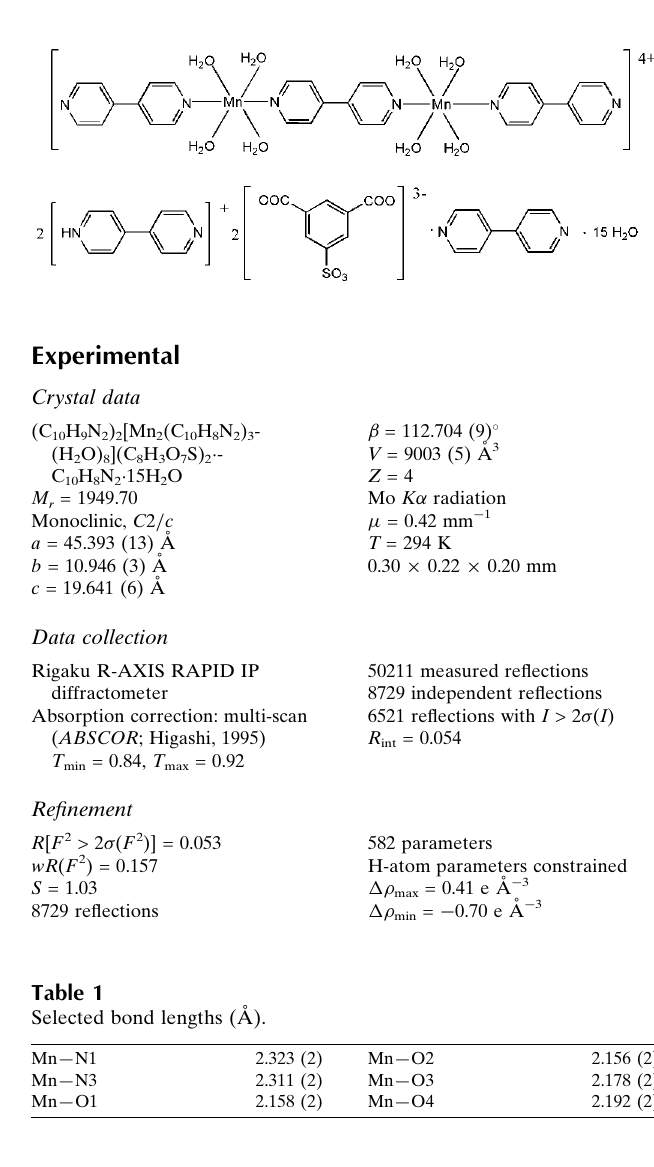
The crystal structure of the title compound, (C (cid:2) C (cid:2) 15H (C H N ) (H O) ](C H O S) H N [Mn 2 10 8 2 3 2 8 8 3 7 2 10 8 2 of dinuclear Mn II complex cations, sulfonatobenzene-